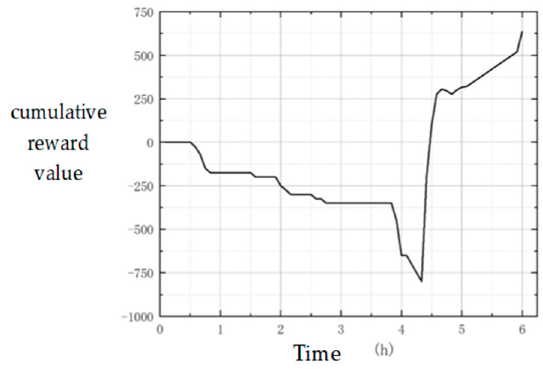
Figure 5. Cumulative reward value in one time step.